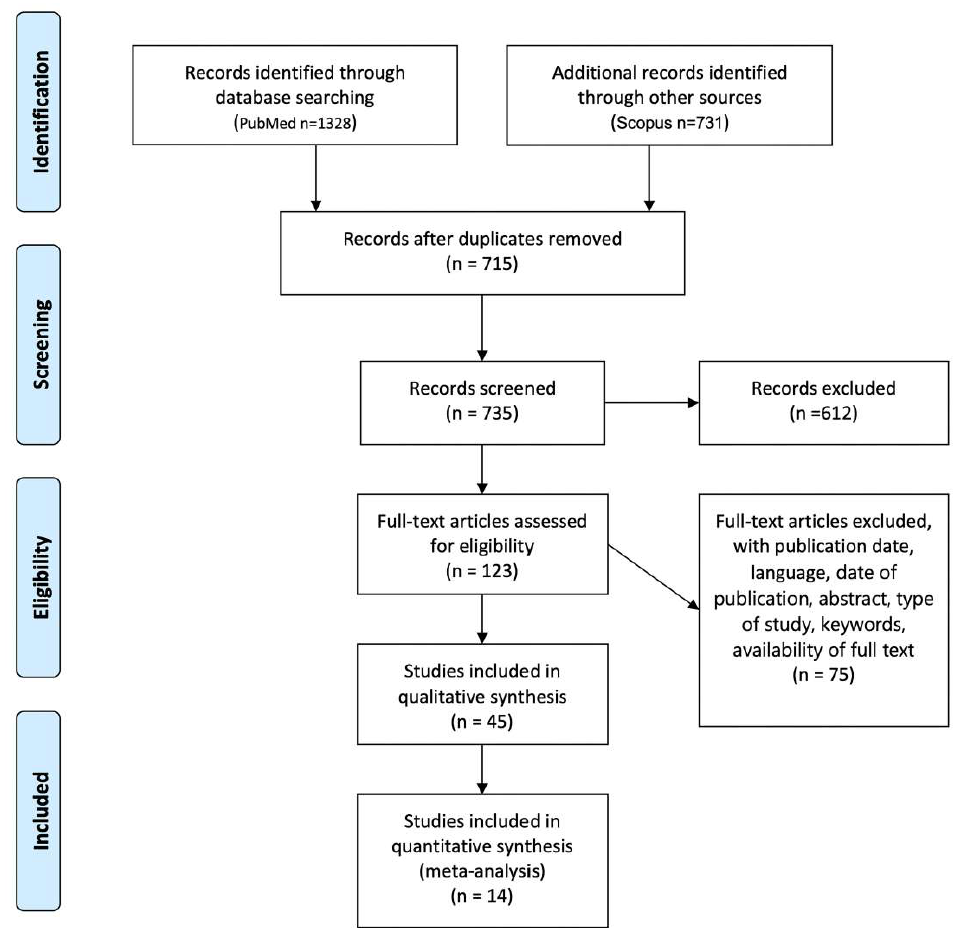
Figure 1. Preferred reporting items for systematic review and meta-analysis (PRISMA) flow diagram for studies retrieved through the searching and selection process.